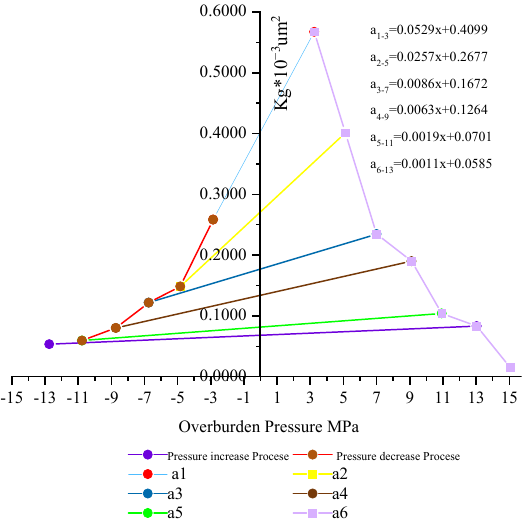
Figure 15. Curve of elastic index variation of a typical core under different stress changes. Through data processing, the correlation distribution between radial compression force and elastic index of the shale core was obtained, as shown in Figure 16. The core elastic index decreased with the increase in radial compression force, and the correlation between the elastic index and the radial compression force was 0.9861, which is a good correlation. It showed that with the increase in radial three-axis compressive force, the core went from elastic deformation to plastic deformation.